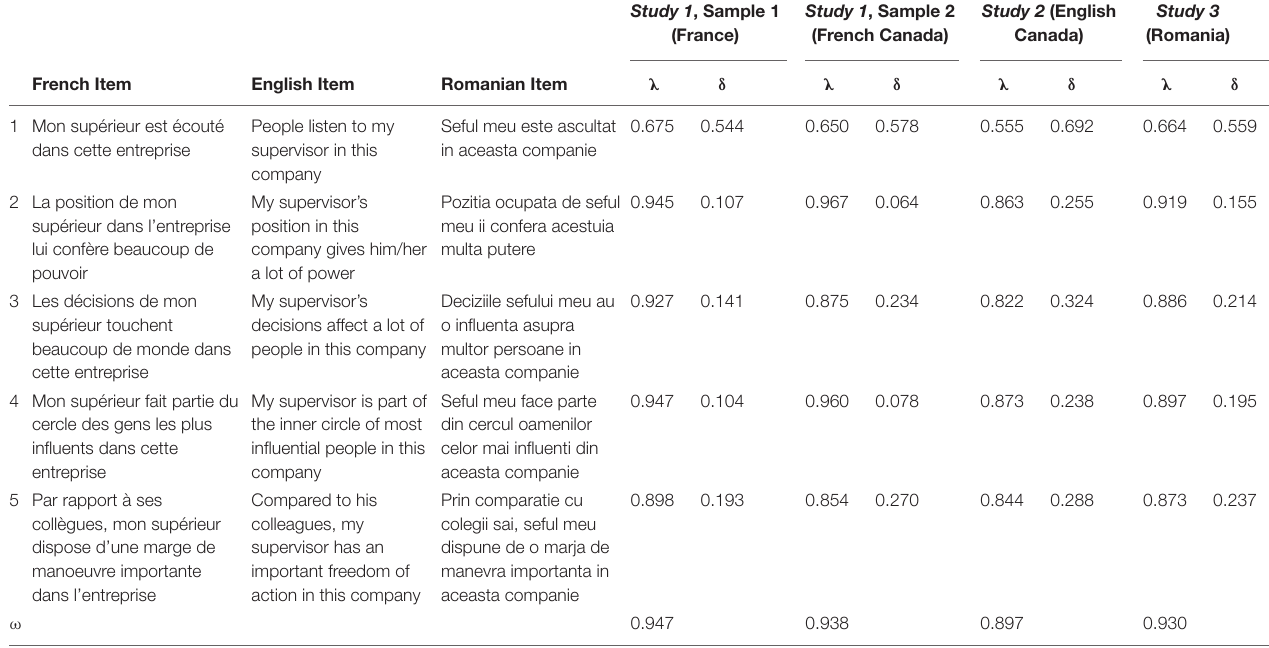
TABLE 3 | Items and Standardized Parameter Estimates for the PSSP